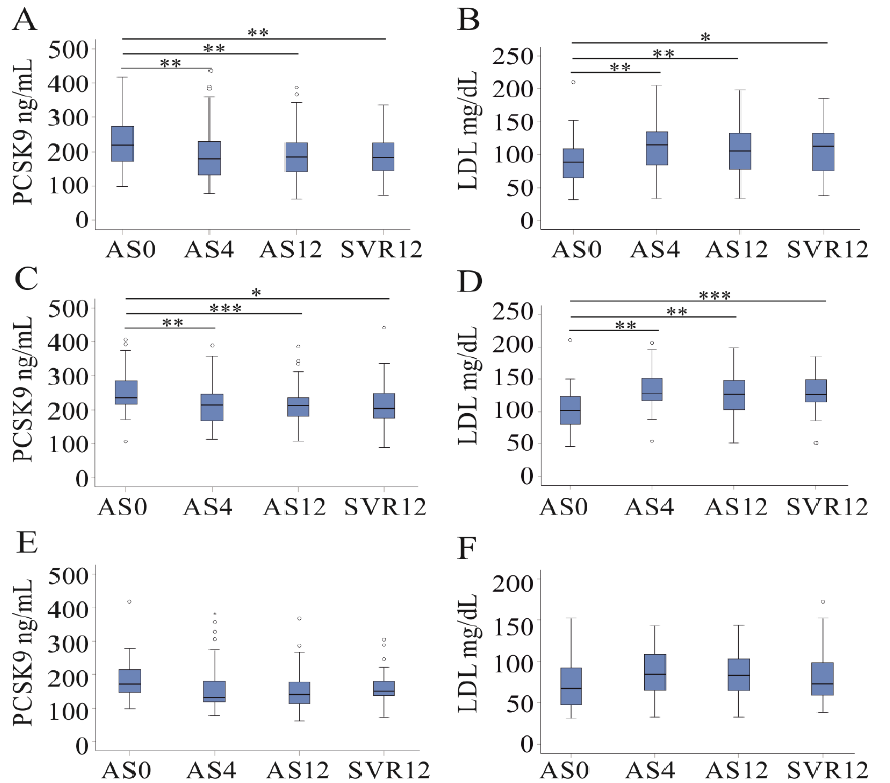
Figure 4. Serum PCSK9 and LDL at 0, 4 and 12 weeks after the start of therapy (AS), and 12 weeks after the end of therapy (SVR12). Serum PCSK9 ( A ) and LDL ( B ) in the whole cohort; serum PCSK9 ( C ) and LDL ( D ) in non-cirrhotic HCV patients; serum PCSK9 ( E ) and LDL ( F ) in cirrhotic HCV patients. Small circles above or below the boxes mark outliers. * p < 0.05, ** p < 0.01 and *** p < 0.001. At all of the time points, serum PCSK9 levels were higher in non-cirrhotic than in cirrhotic patients ( p < 0.001 for 4 and 12 weeks after therapy start and for 12 weeks posttreatment). At 12 weeks posttreatment, the associations of serum PCSK9 with the MELD score, bilirubin, INR, leukocytes and CRP in the patients with liver cirrhosis persisted. At this time point, a positive correlation of PCSK9 and LDL was observed (Table